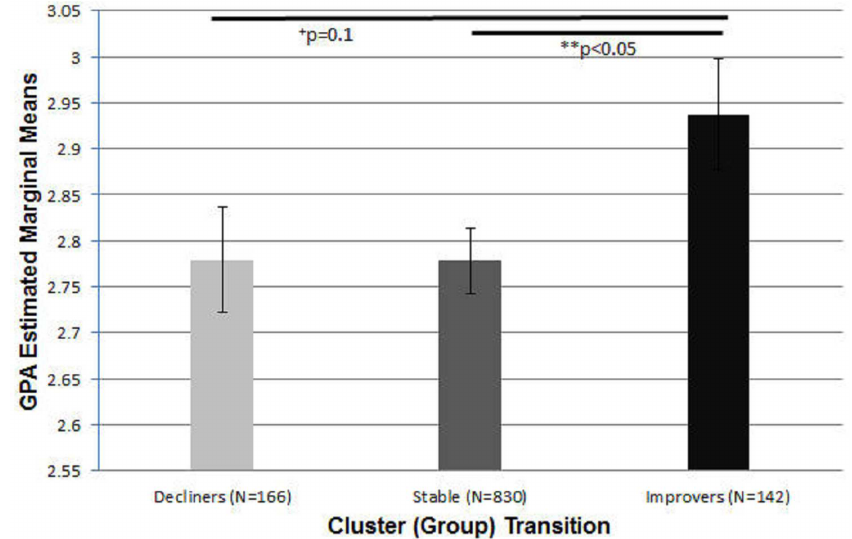
Fig 4. Bar plot of GPA (estimated marginal means) across cluster (group) transitioners from our pseudo trajectoryanalysis. Post-hoc between-group analysis(using a Sidak correction for multiple comparisons) is also indicated. The Improver group representsstudents that went from a worse substance use cluster to a better one over the periodof the study. Declinerswere the oppositeof improvers. Stable group participants started and ended the study in the same substance use cluster. Note: Error bars represent standarderror of mean.